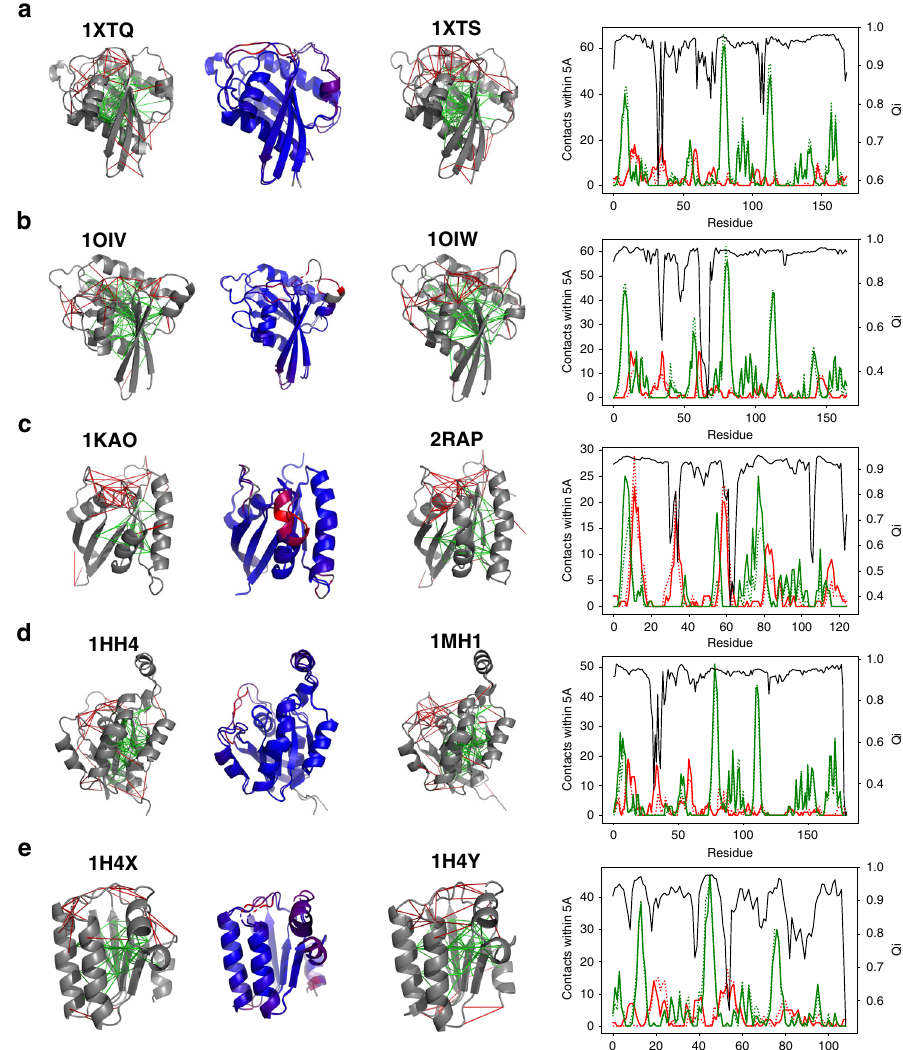
Fig. 2 Gallery of the localized frustration and minimally frustrated networks in allosteric proteins. A structural alignment of both experimentally determined conformations is shown at the center, colored according to the structure deviation (blue low and red high). The individual conformations are shown at the sides. The protein backbone is displayed as cartoons, the interresidue interactions with solid lines. Minimally frustrated interactions are shown in green, highly frustrated interactions in red, neutral contacts are not drawn. At right, a quanti fi cation of the minimally frustrated interactions (green) or highly frustrated interactions (red) in the vicinity of each residue in a 1XTQ and 1XTS, b 1OIV, and 1OIW, c 1KAO and 2RAP, d 1HH4 and 1MH1, and e 1H4X and 1H4Y. The local Qi of each residue is shown in black. The quanti fi cations of the interactions in the two con fi gurations are shown in solid lines and dashed lines separately. We can see that the two patterns are strongly correlated with most minimally frustrated regions being nearly the same in both and the location of the frustrated regions typically only shifting by a few residues or becoming minimally